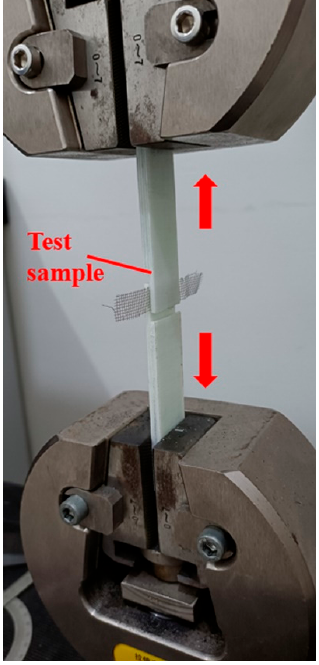
Figure 6. Test setup.